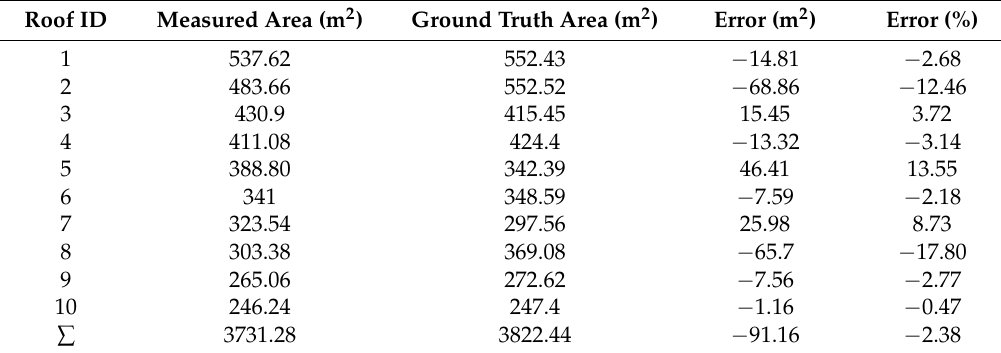
Table 2. Results for the Historic Centre data sample.